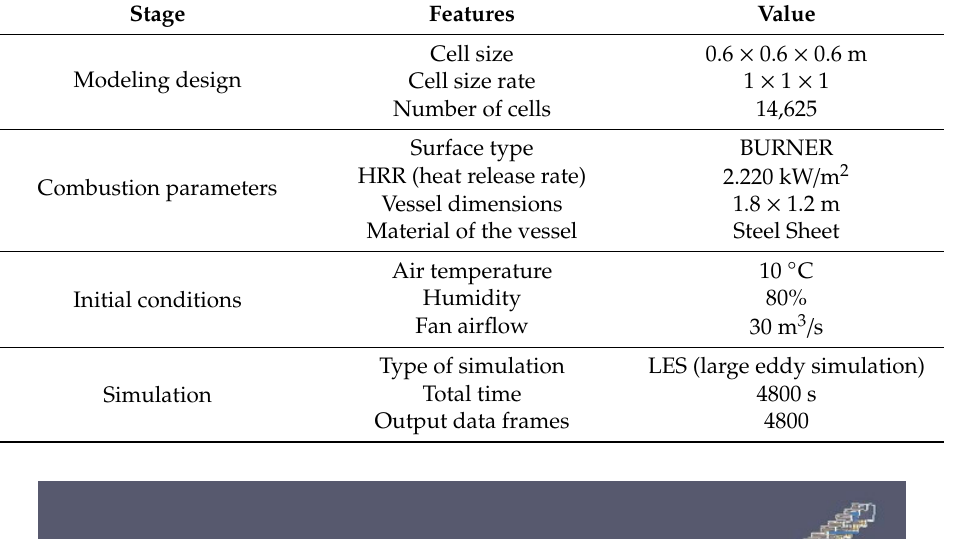
Table 3. Modeling features.